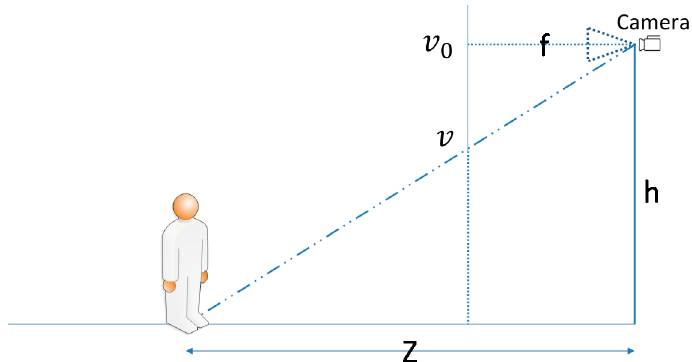
Figure 12. Diagram of distance calculation.